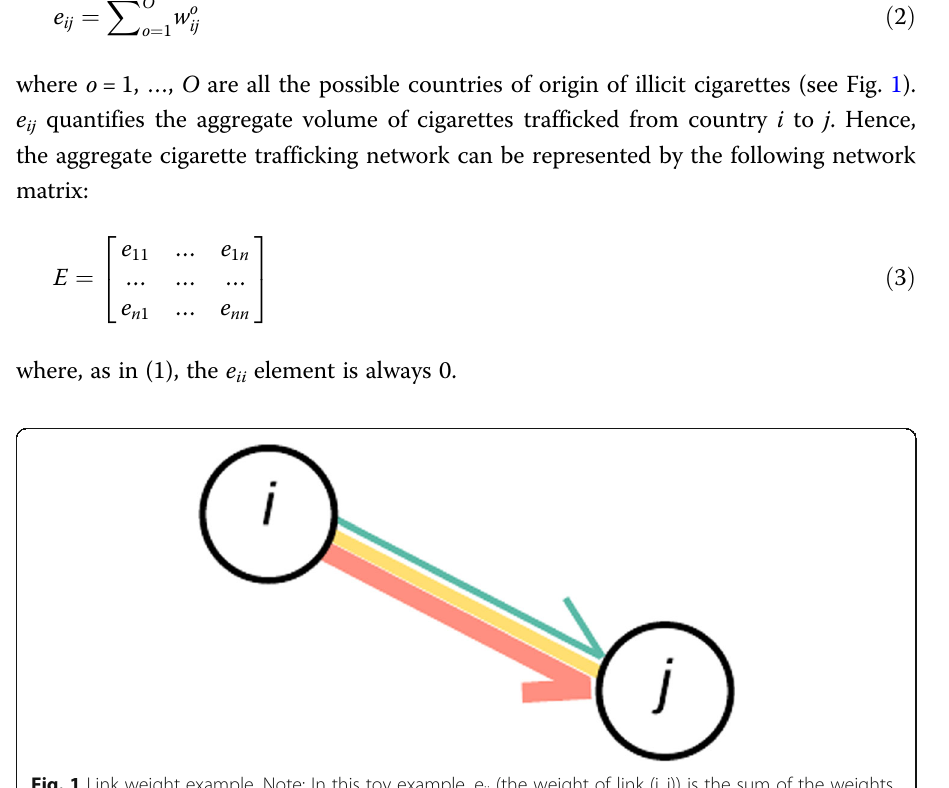
Fig. 1 Link weight example. Note: In this toy example, e ij (the weight of link (i, j)) is the sum of the weights of three ‘ origin-specific ’ trafficking networks: w o